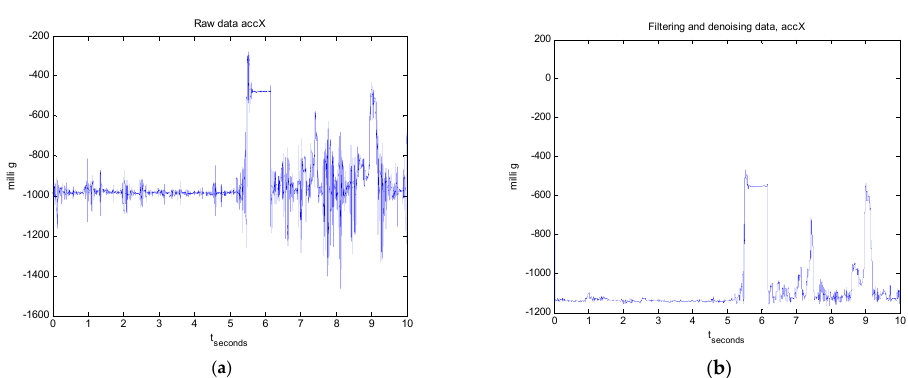
Figure 3. Measurements recorded for user 1 and experiment 1 for a 3-axial acceleration sensor located on the up right knee: ( a ) raw data; and ( b ) after applying 2-stage